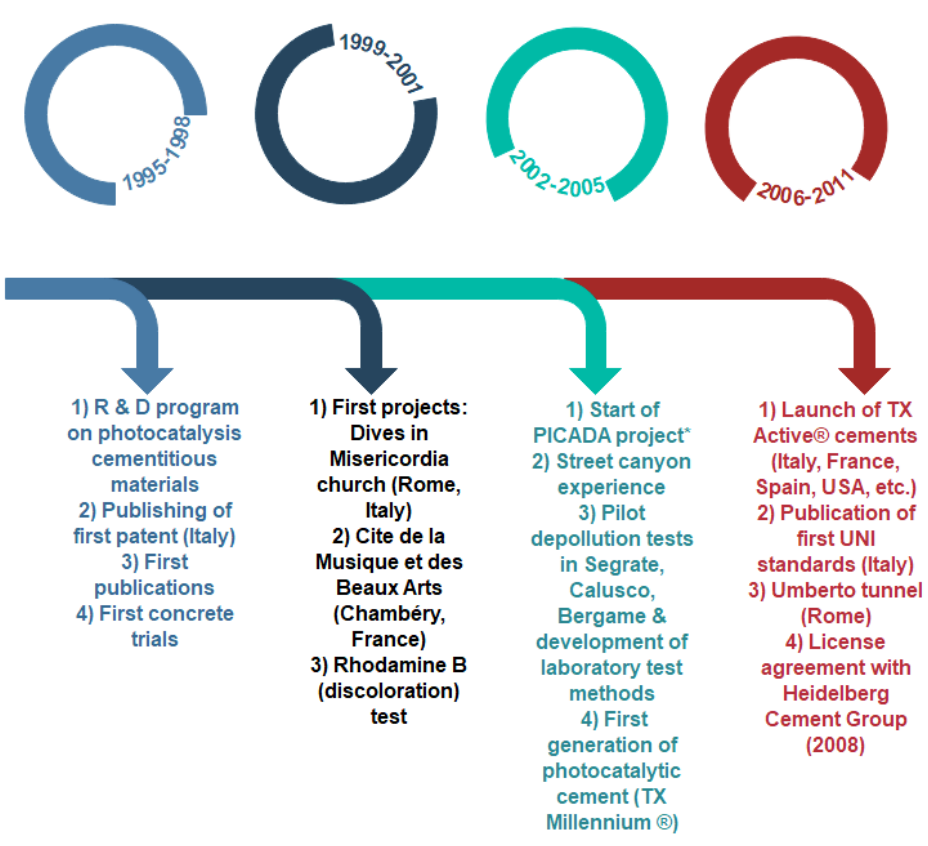
Figure 5. History of photocatalysis cementitious materials [6,41,42]. (Note: PICADA project: European